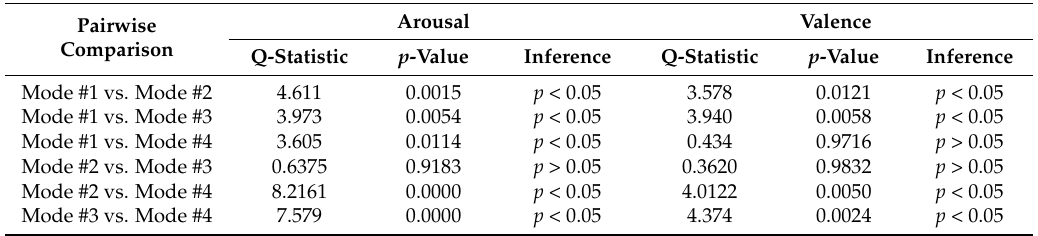
Table 2. Result of statistical significance of Tukey–Kramer HSD test in the arousal and valence recognition rate.